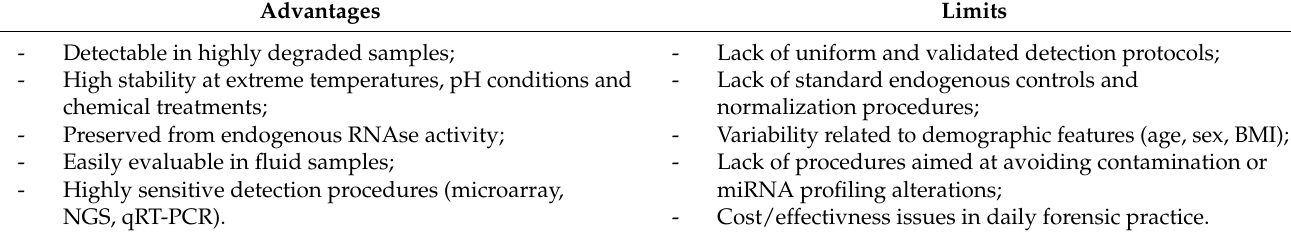
Table 2. Summary of the main advantages and limits of miRNA profiling application to the post mortem diagnosis of